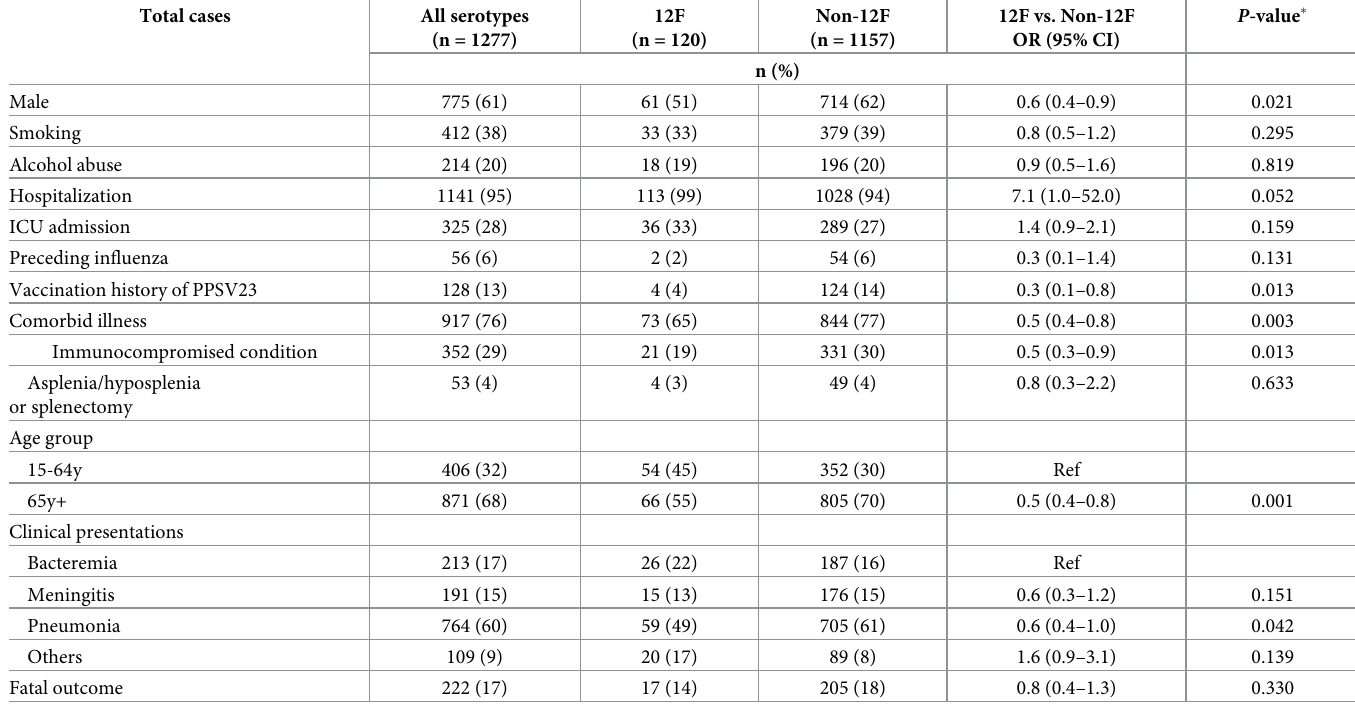
Table 1. Comparison of clinical parameters in adult patients with IPD caused by 12F serotype and non-12F serotypes. Total cases